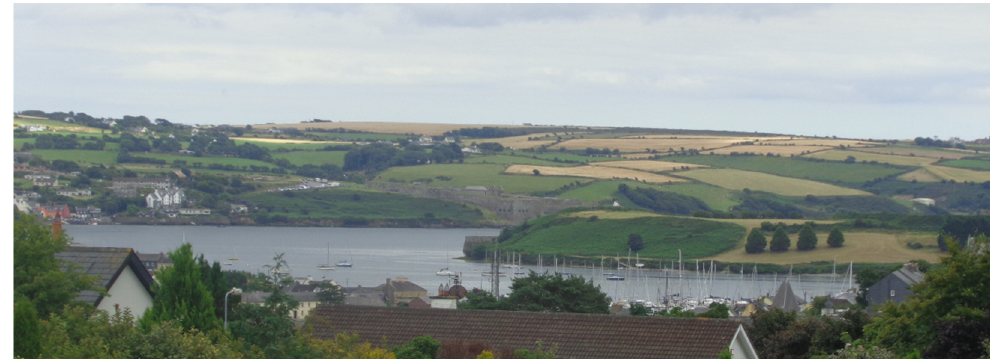
Figure 4. The identification of a marina unit’s environment, Kinsale, IE. Figure 9. The identification of a marina unit’s environment, Kinsale,